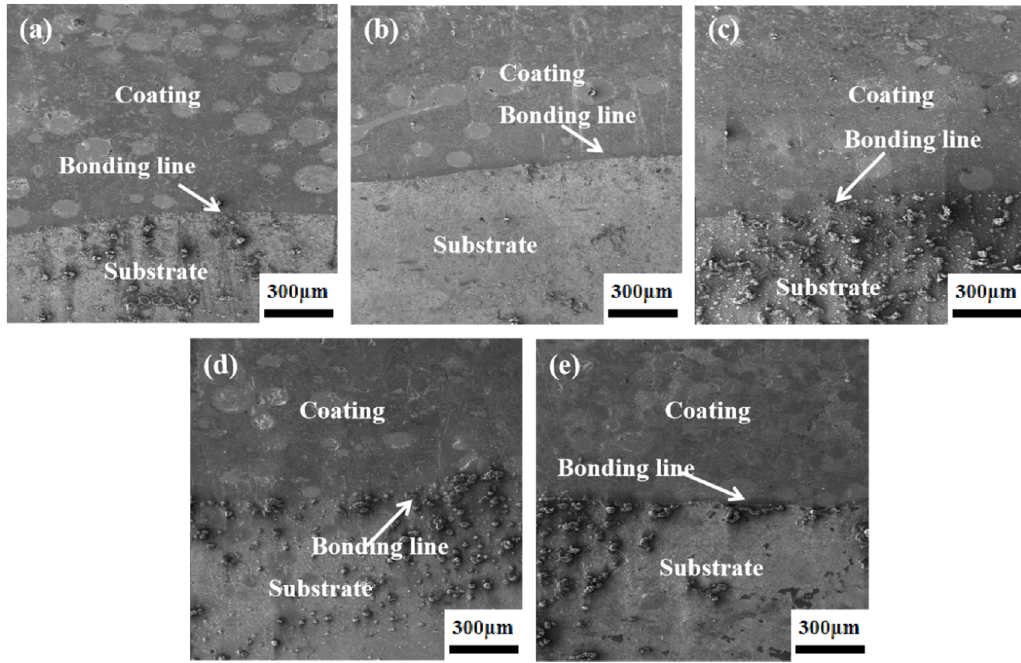
Figure 5: The interfacial morphologies between the coating and the substrate in ( a ) S1, ( b ) S2, ( c ) S3, ( d ) S4 , and ( e )